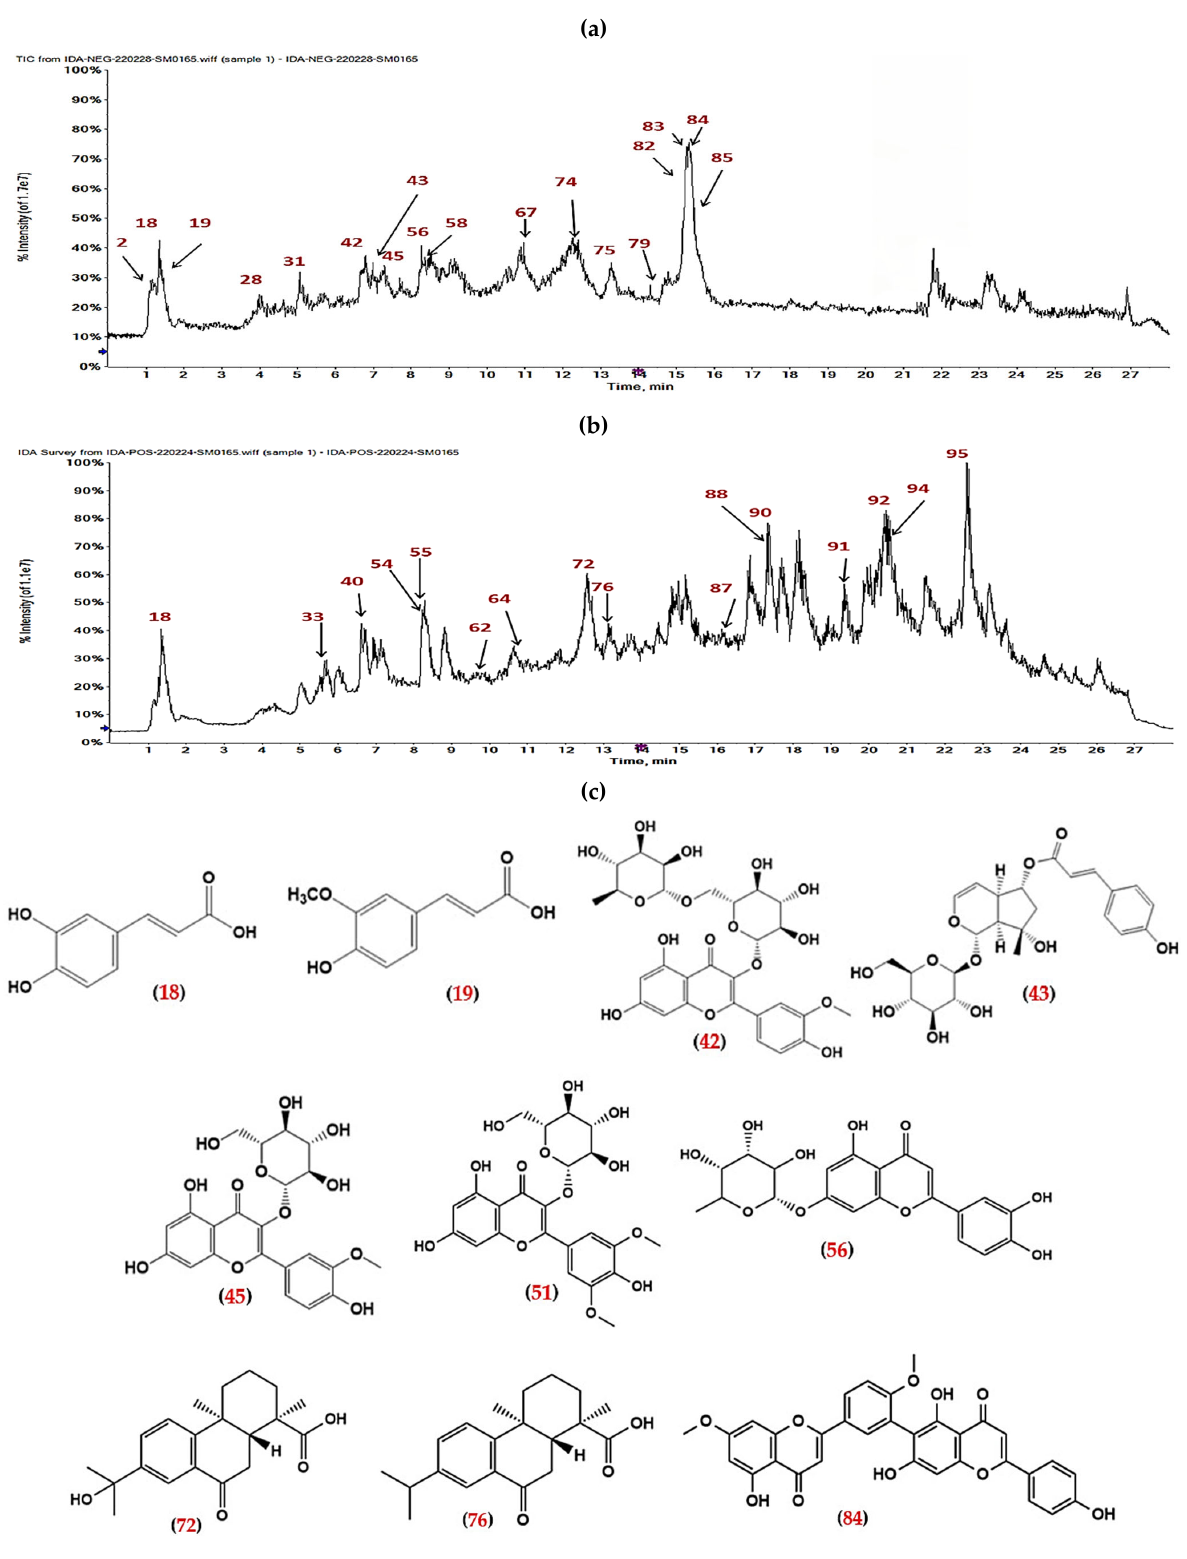
Figure 2. LC ‐ MS total ion chromatograms of ARBE . ( a ) The TIC in negative ion mode. ( b ) The TIC Figure 2. LC-MS total ion chromatograms of ARBE. ( a ) The TIC in negative ion mode. ( b ) The TIC in in positive ion mode. ( c ) The structure of some LC ‐ MS identified major components of ARBE. Num ‐ positive ion mode. ( c ) The structure of some LC-MS identified major components of ARBE. Numbers bers in red (in ( a – c )) are related to Table 1. in red (in ( a – c )) are related to Table